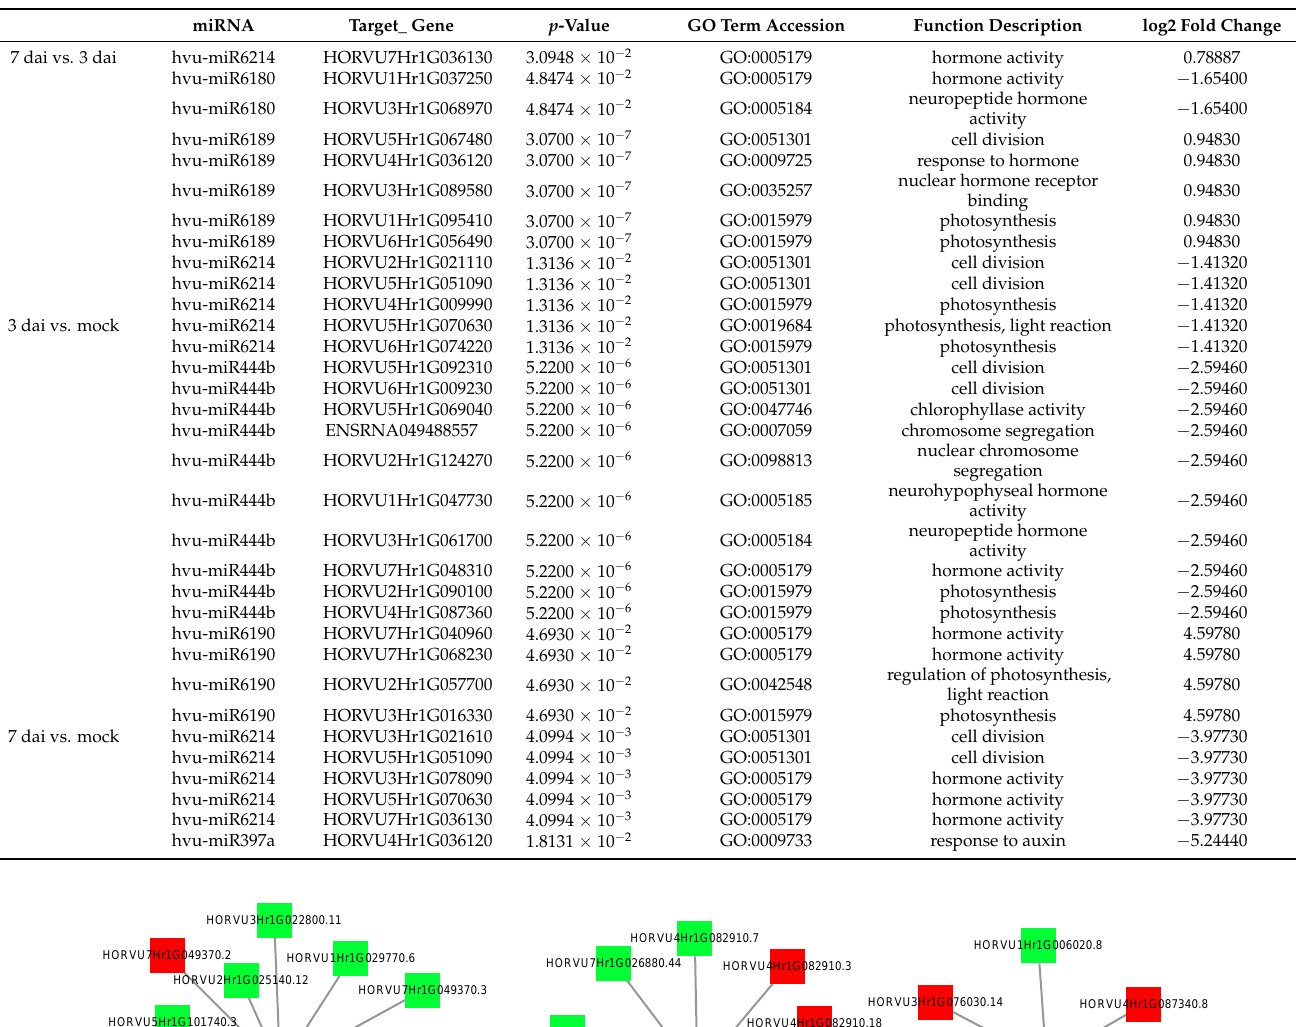
Table 7. Examples of miRNAs and their up-and downregulated targets in barley.